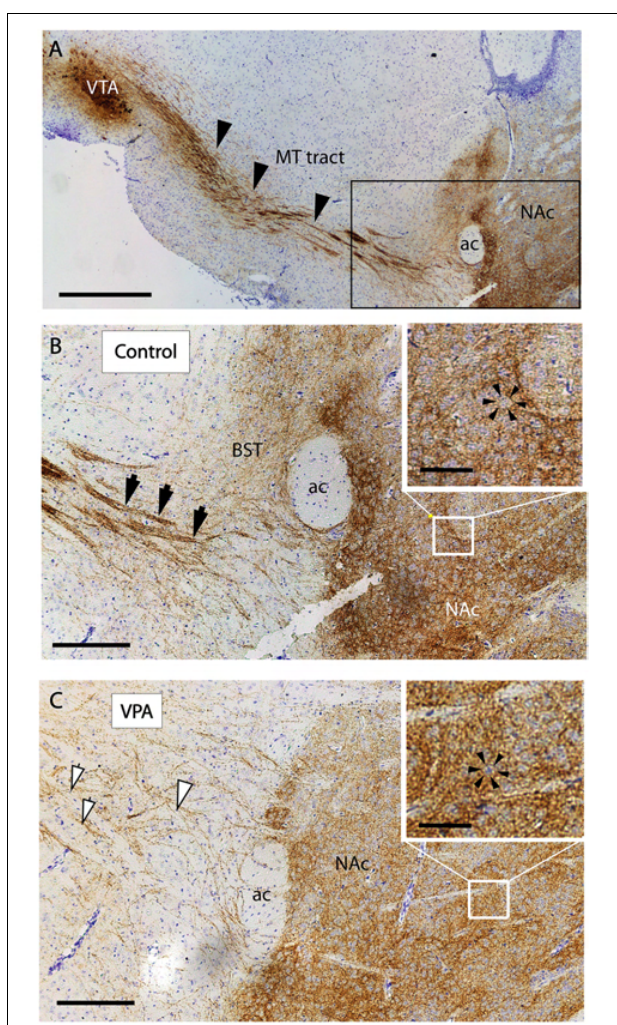
FIGURE 8 | Course and distribution of the mesotelencephalic dopaminergic pathway in control and VPA exposed P7 mice. Paraffin-embedded sagittal sections immunolabeled against TH and counterstained with cresyl violet. (A) Low power image from control specimen, depicting the path of TH+ fibers (arrowheads) from their origin (ventral tegmental area, VTA) to the ventrobasal forebrain (i.e., centered on the mesolimbic part of the tract). Matching pair of enlarged images from control (B) and VPA exposed (C) specimens, taken at the border of the ventrobasal target area, through which the TH+ fibers pass to terminate (marked by the frame in A ). The photomicrographs also demonstrate the difference between the two samples in the degree of fasciculation. The control displays robust fascicles (filled arrowheads), whereas the VPA is characterized by thin, less visible fascicles and more dispersed fibers (open arrowheads). On entering the target region, the TH+ fibers tend to form “dopaminergic islands,” marked by arrowheads (insets of B,C ). Abbreviations: ac, anterior commissure; BST, bed nucleus of stria terminalis; MT, mesotelencephalic tract; NAc, nucleus accumbens.